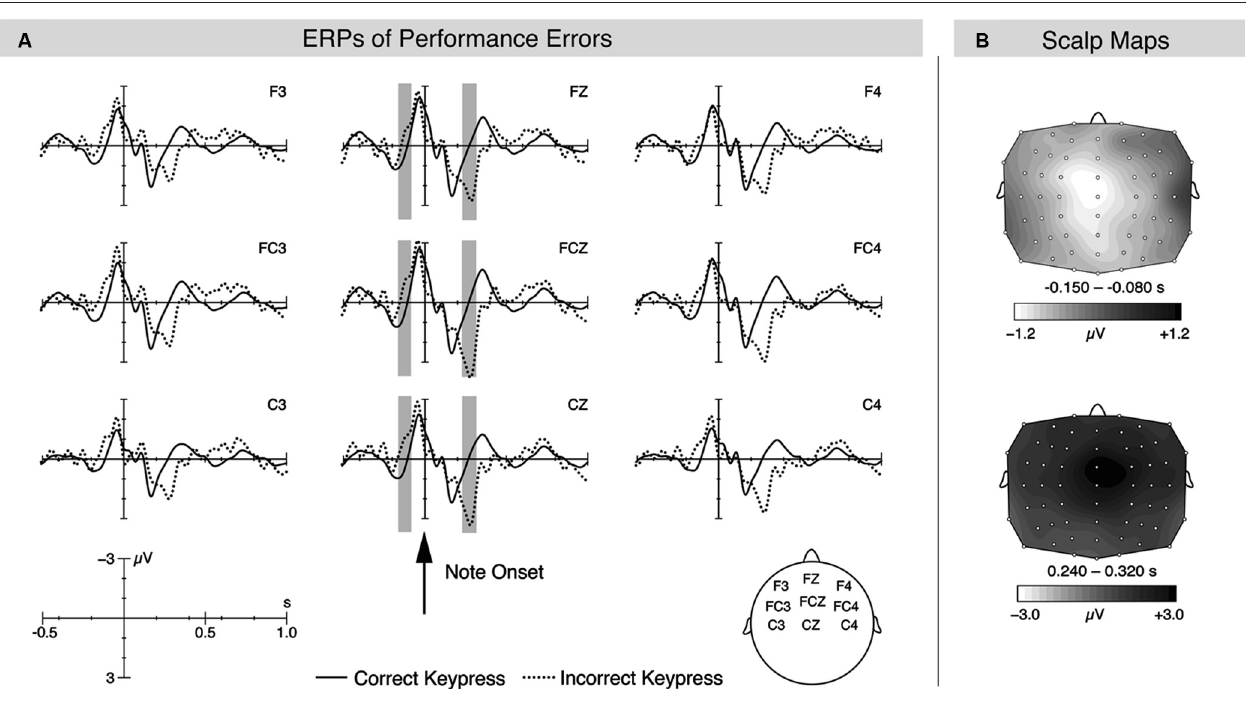
time windows used for statistical analysis (–150 to –80 ms and 240–320 ms). (B) shows the scalp distributions for the difference potential for correct keystrokes subtracted from incorrect keystrokes. Figure taken from Maidhof et al.